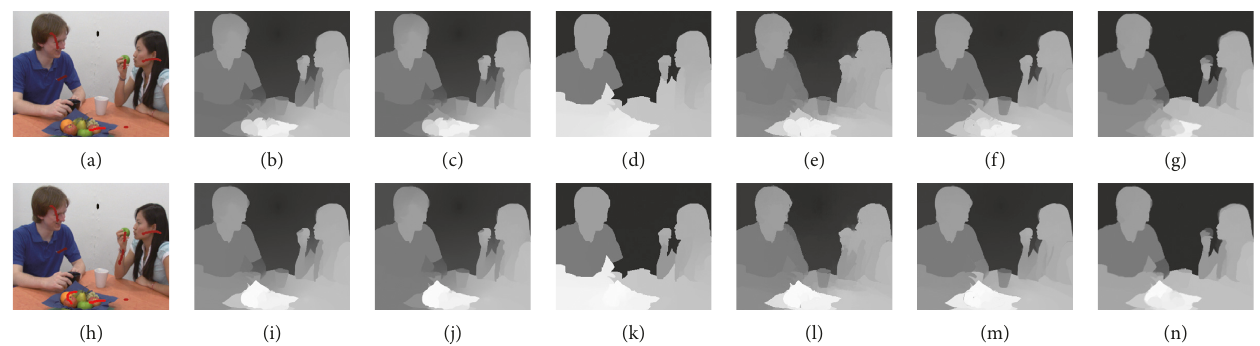
Figure 12: Results of depth for RGBZ_01 with sparse input. (a) User scribbles 1. (b) Depth of RW for scribbles 1. (c) Depth of OPT for scribbles 1. (d) Depth of HGR for scribbles 1. (e) Depth of SOPTfor scribbles 1. (f) Depth of NRW for scribbles 1. (g) Depth of proposed